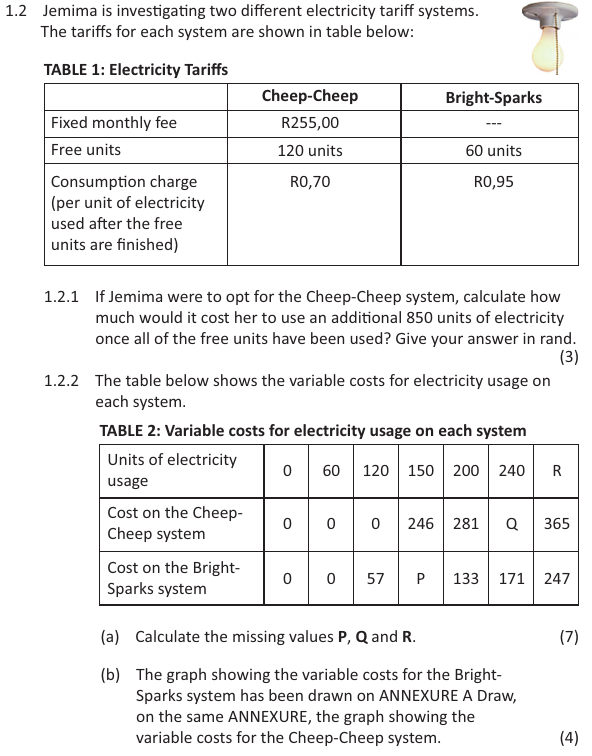
TABLE 1: Categorisation of the exemplar examination questions according to Dowling’s (1998) domains of practice